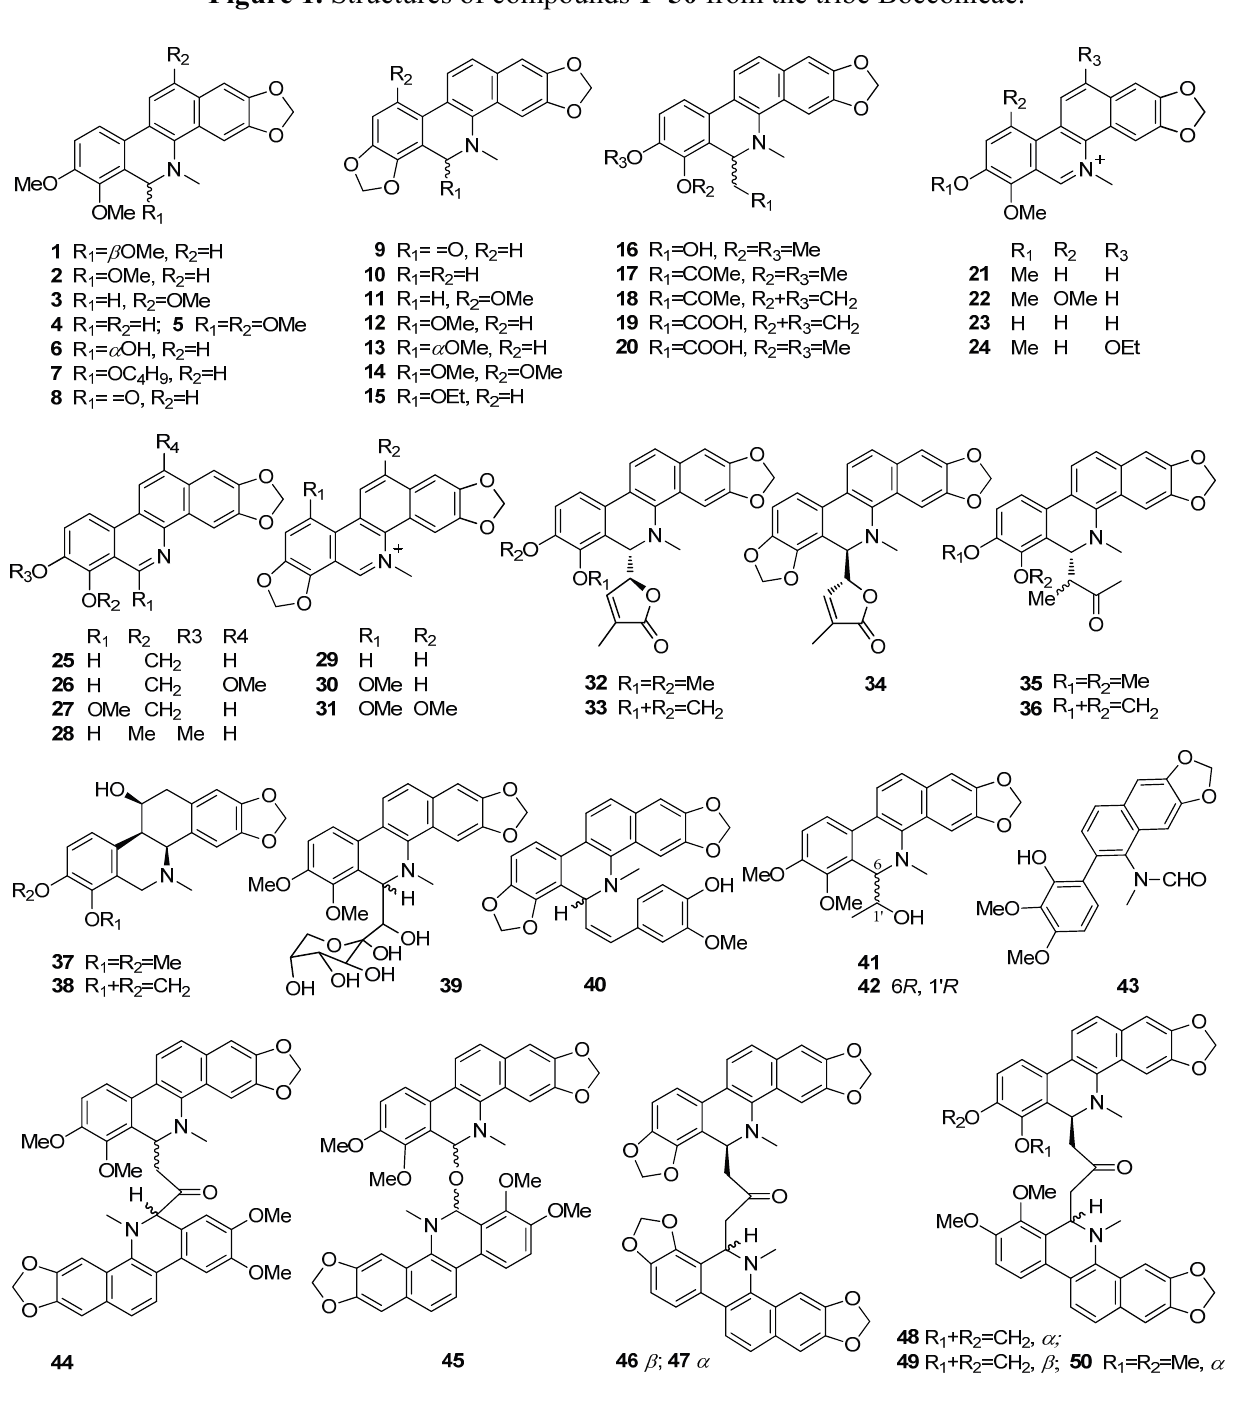
Figure 1. Structures of compounds 1 – 50 from the tribe